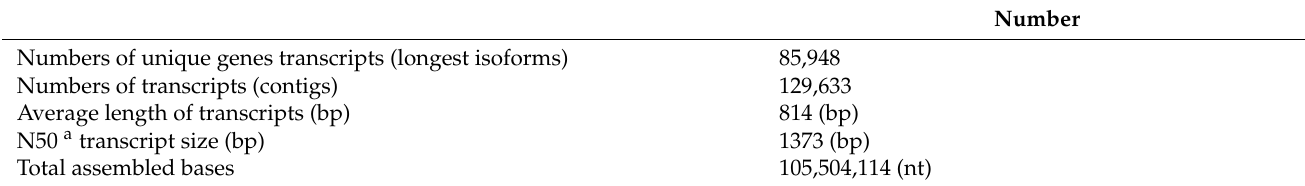
Table 2. Statistical summary of de novo transcriptome